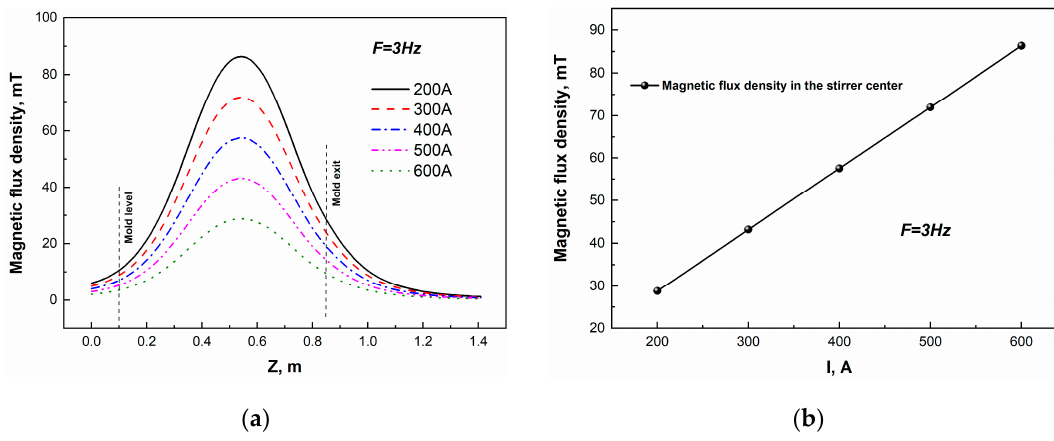
Figure 12. Distribution of magnetic flux density under different current intensities: ( a ) along the strand central axis; ( b ) in the stirrer center.